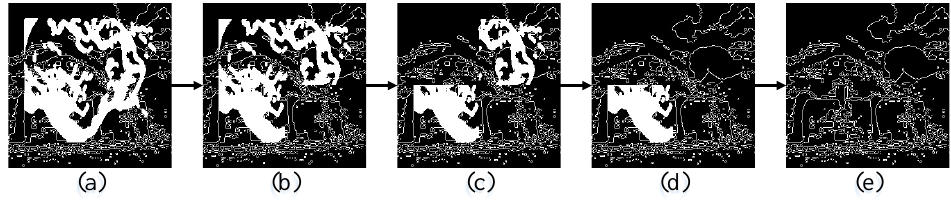
Figure 3. Multi-step structural reconstruction process. ( a ) represents a masked image, ( b – d ) depict the inpainting results from the first to third steps, and ( e ) shows the final structural reconstruction